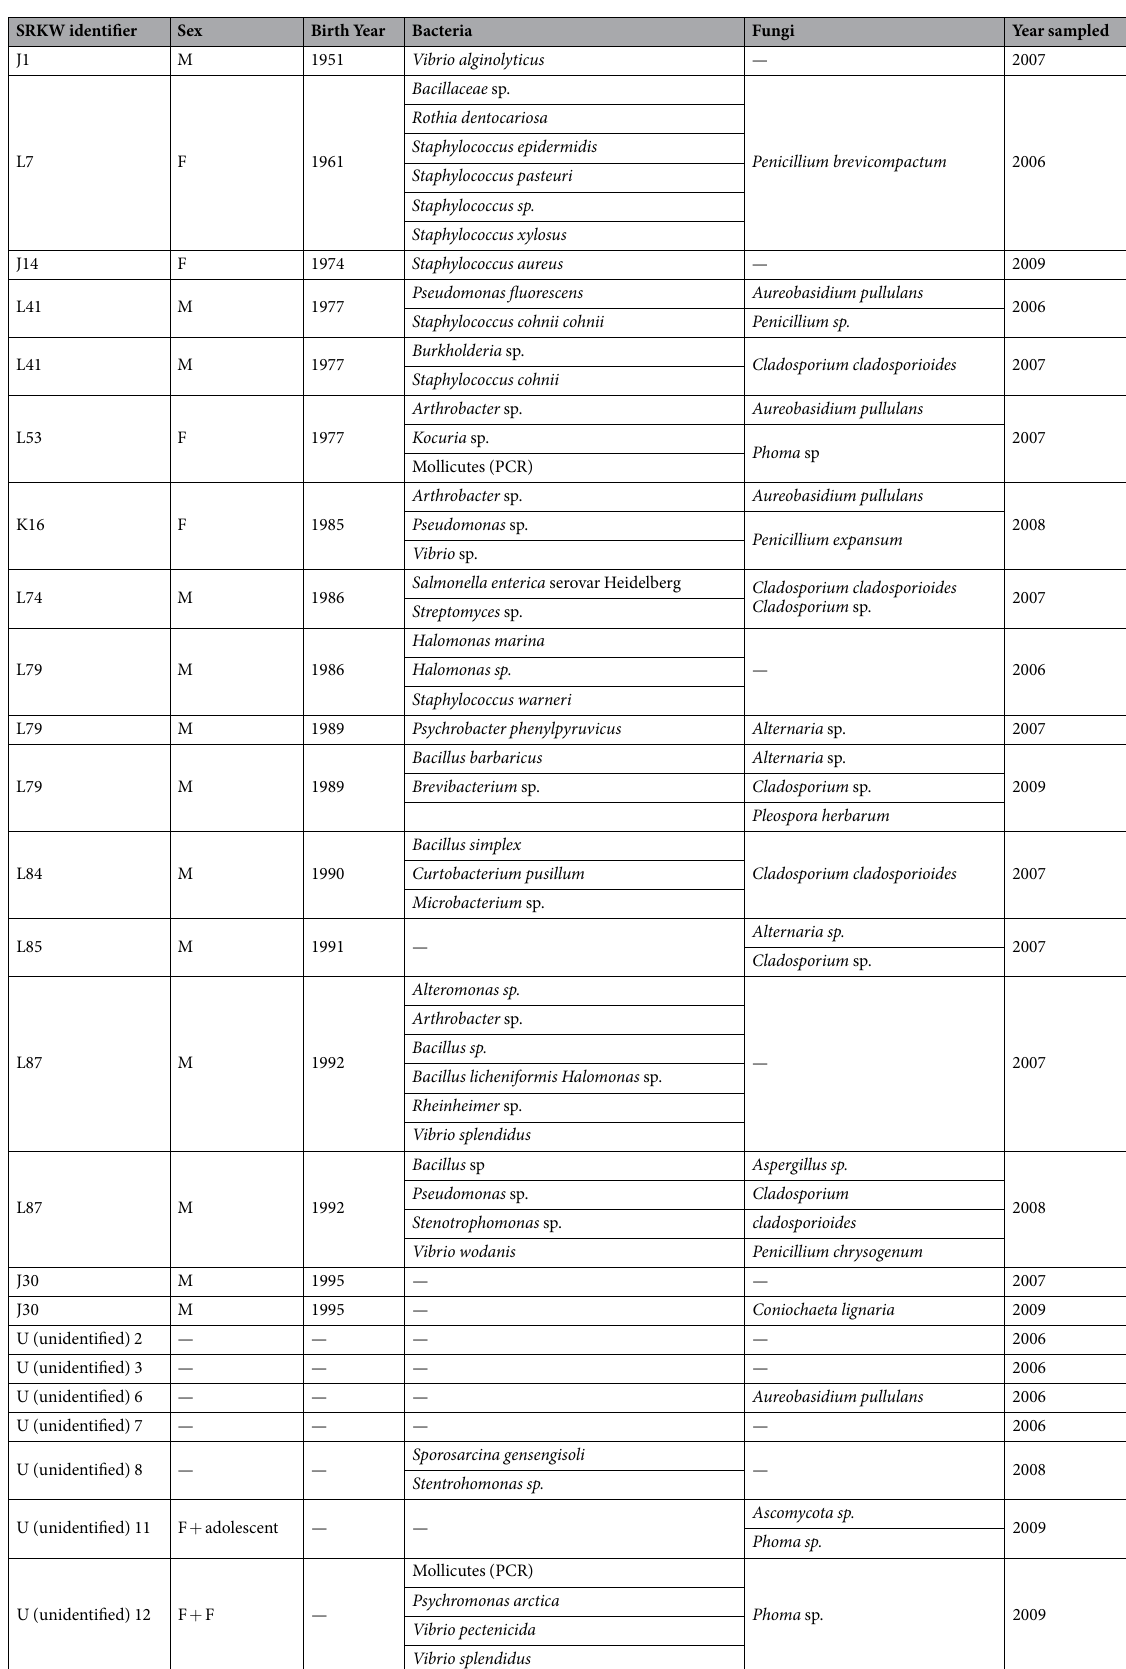
Table 1. List of bacteria and fungi detected in exhaled breath samples collected from